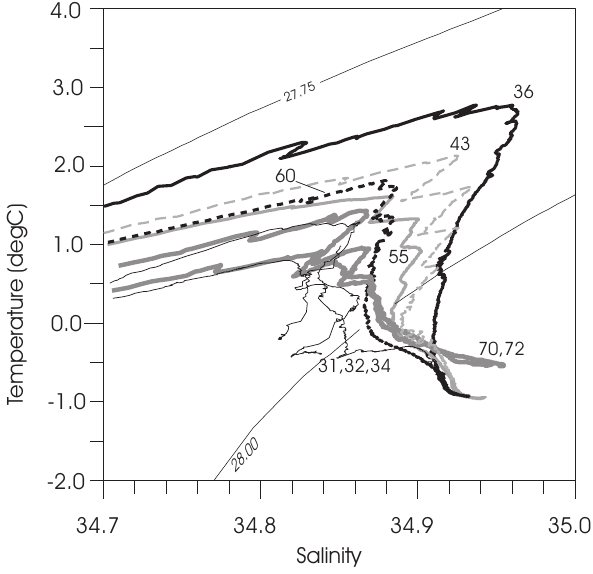
Fig. 6. Potential temperature vs. salinity along the cross-basin sec- tion (see Figs. 1 and 5). Stations 31, 32, 34 represent the Barents Sea inflow; station 36, the Fram Strait Atlantic water inflow; sta- tion 43, the Nansen Basin interior; station 55, the Amundsen Basin; station 60, western slope of the Lomonosov Ridge; and stations 70 and 72, the Makarov Basin.